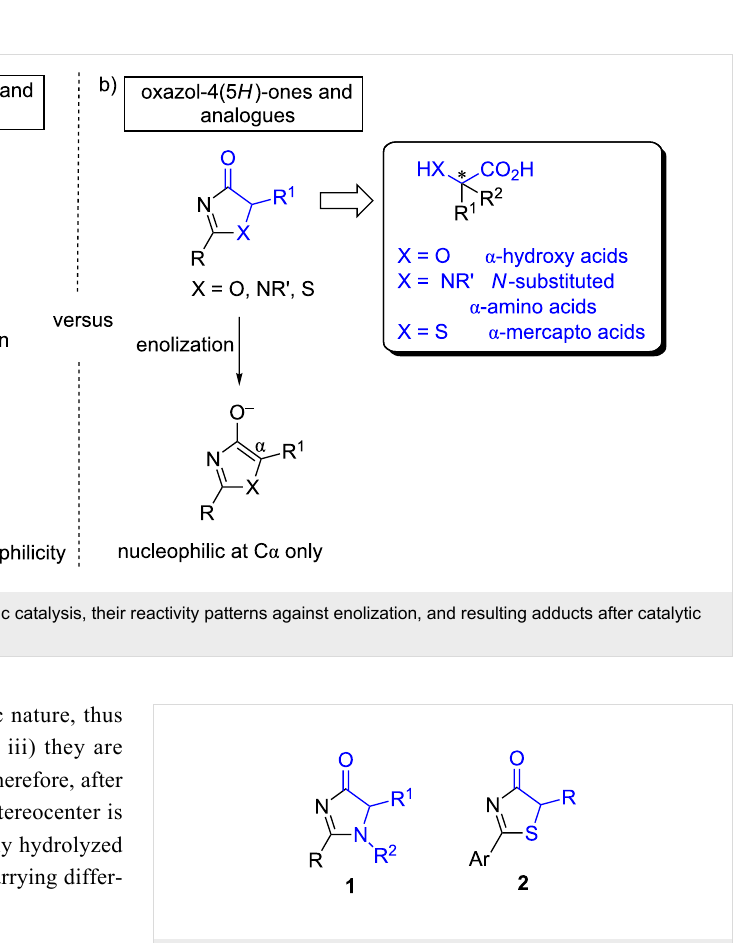
Figure 2: 1 H -Imidazol-4(5 H )-ones 1 and thiazol-4(5 H )-ones 2 .